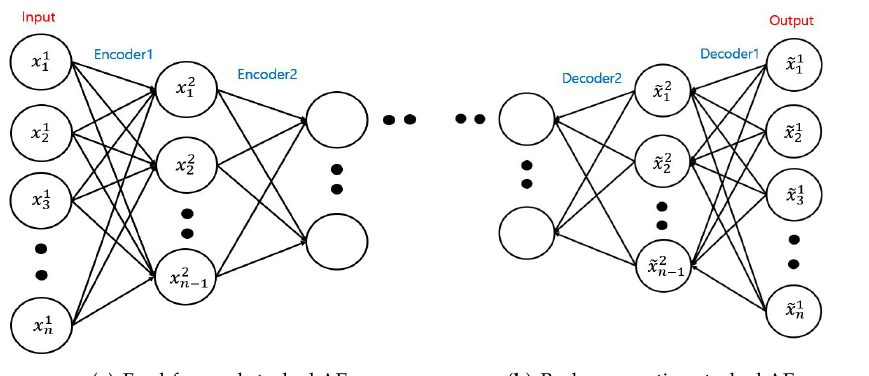
Figure 5. Architectures of stacked AEs.